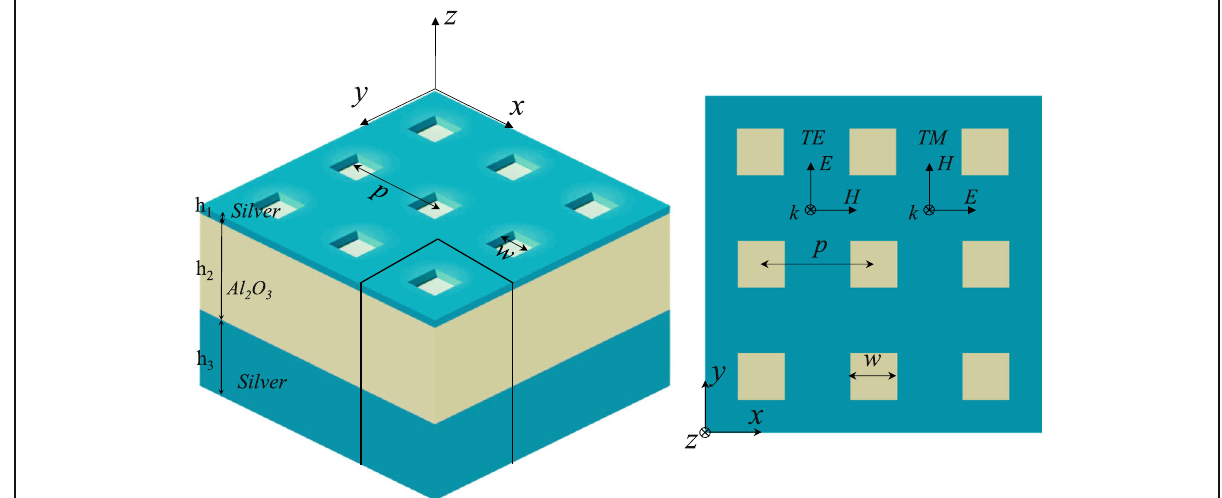
Fig. 1 Schematic view of the proposed nanohole array-based